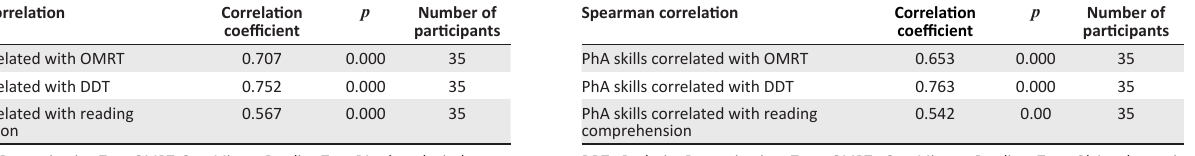
TABLE 4: Phonological awareness skills correlated with reading skills. Spearman correlation